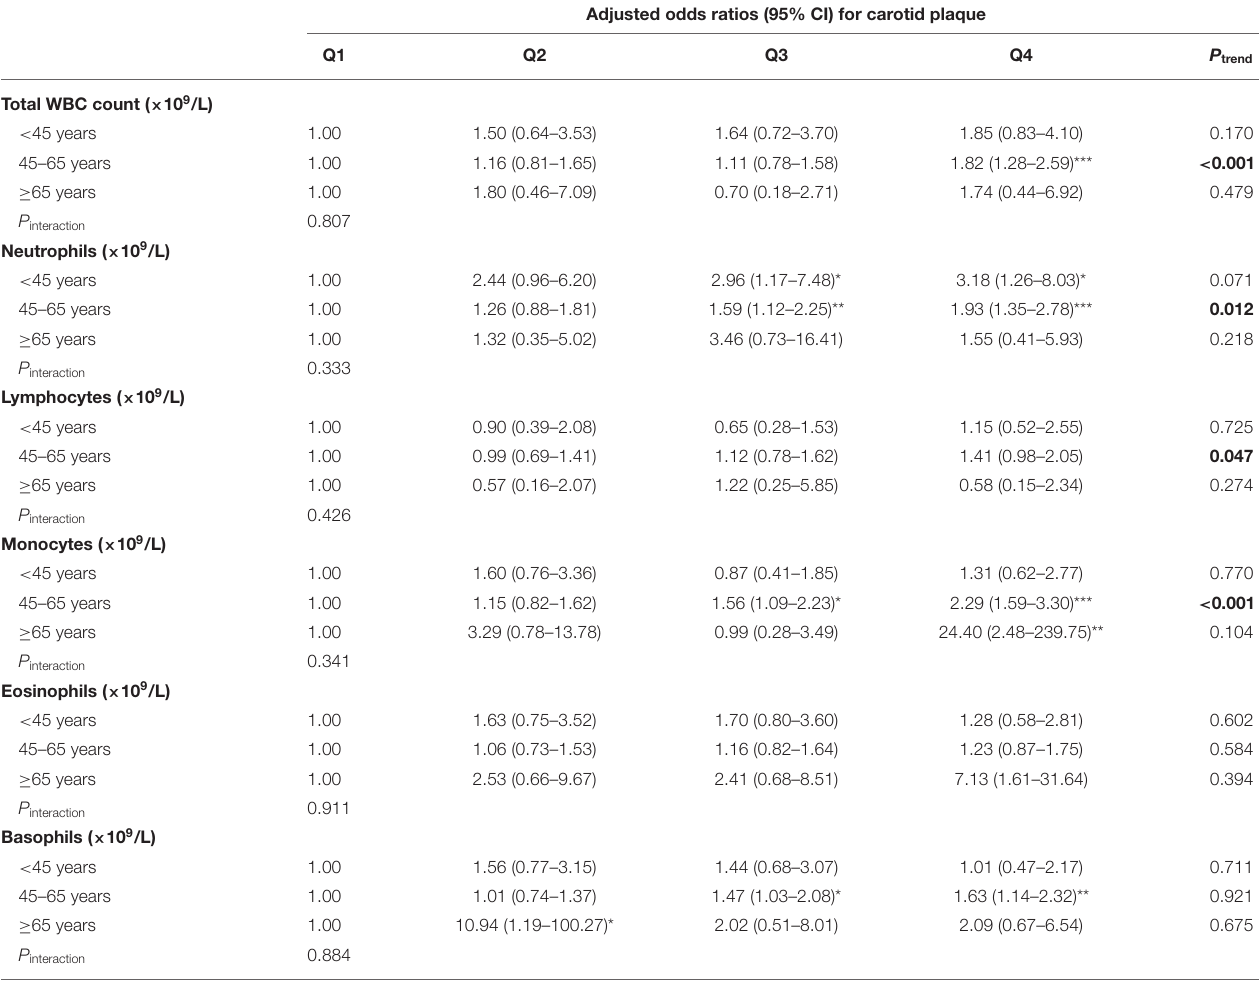
TABLE 4 | Adjusted odds ratios and 95% CI for carotid artery plaque stratified by age for men.